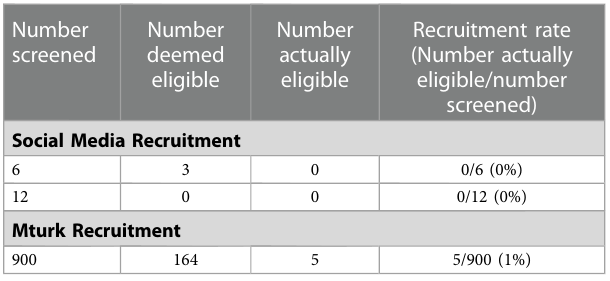
TABLE 1 Online recruitment